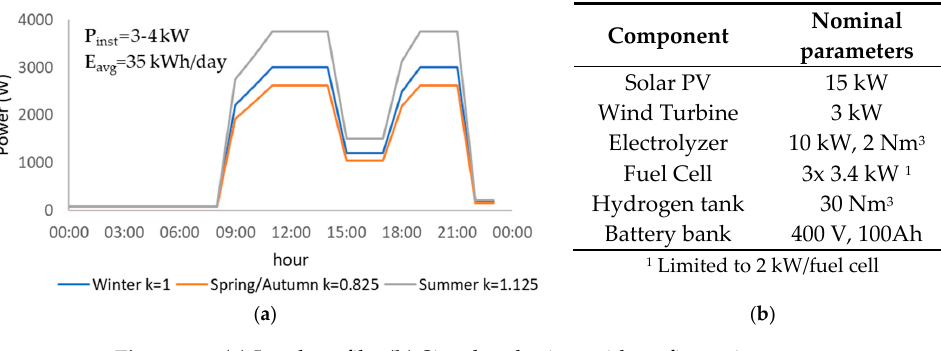
Figure 19. (a) Load profile; (b) Simulated microgrid configuration setup. Figure 19. ( a ) Load profile; ( b ) Simulated microgrid configuration setup. Table 4. Hydrogen-priority and battery-priority strategies input Table 4. Hydrogen-priority and battery-priority strategies input parameters.